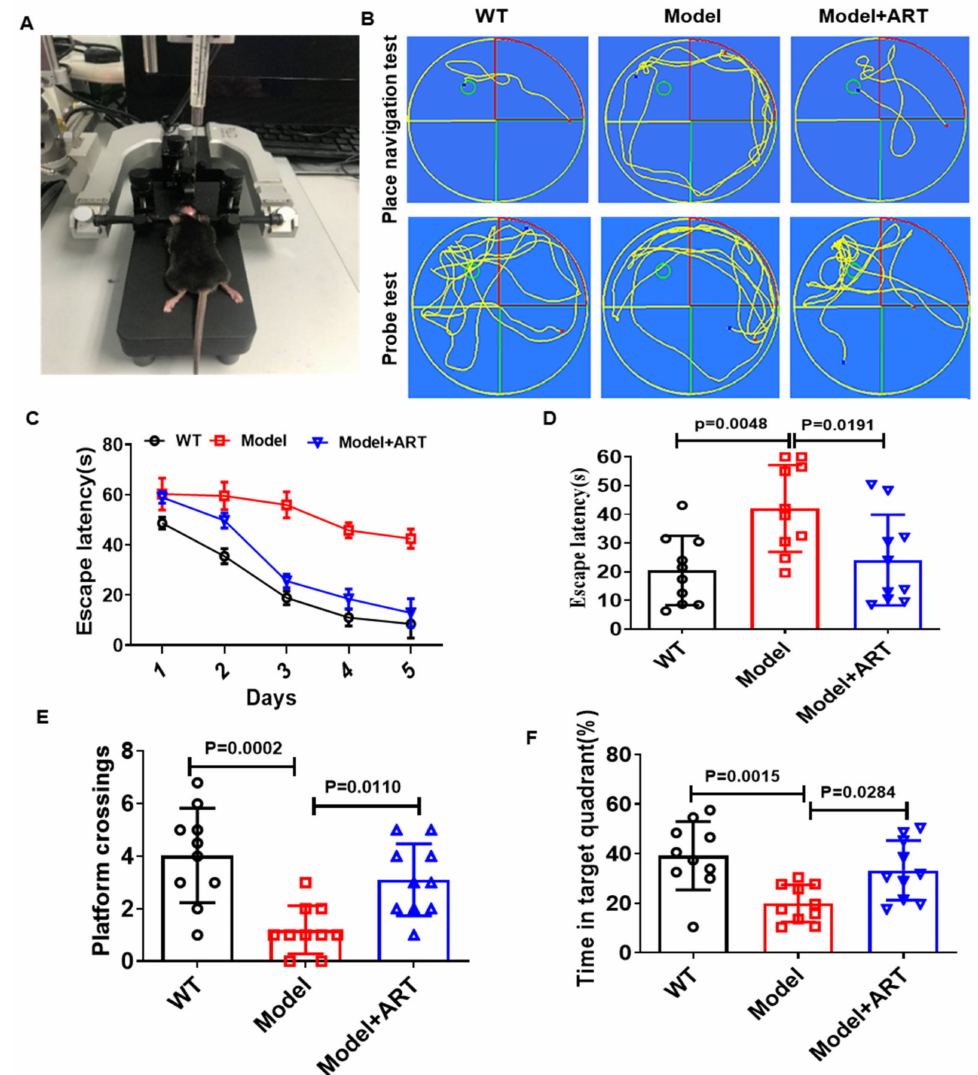
Figure 6. Artemisinin treatment improved the learning and memory of AD model mice. ( A ) Schematic of the experimental model. ( B ) The representative curve of probe test and place navigation test. ( C , D ) Time is required to find the hidden platform. ( E ) The number of times each group of mice crossed the hidden platform. ( F ) The percentage of time spent in the target quadrant of each group of mice. p < 0.05 was considered significantly